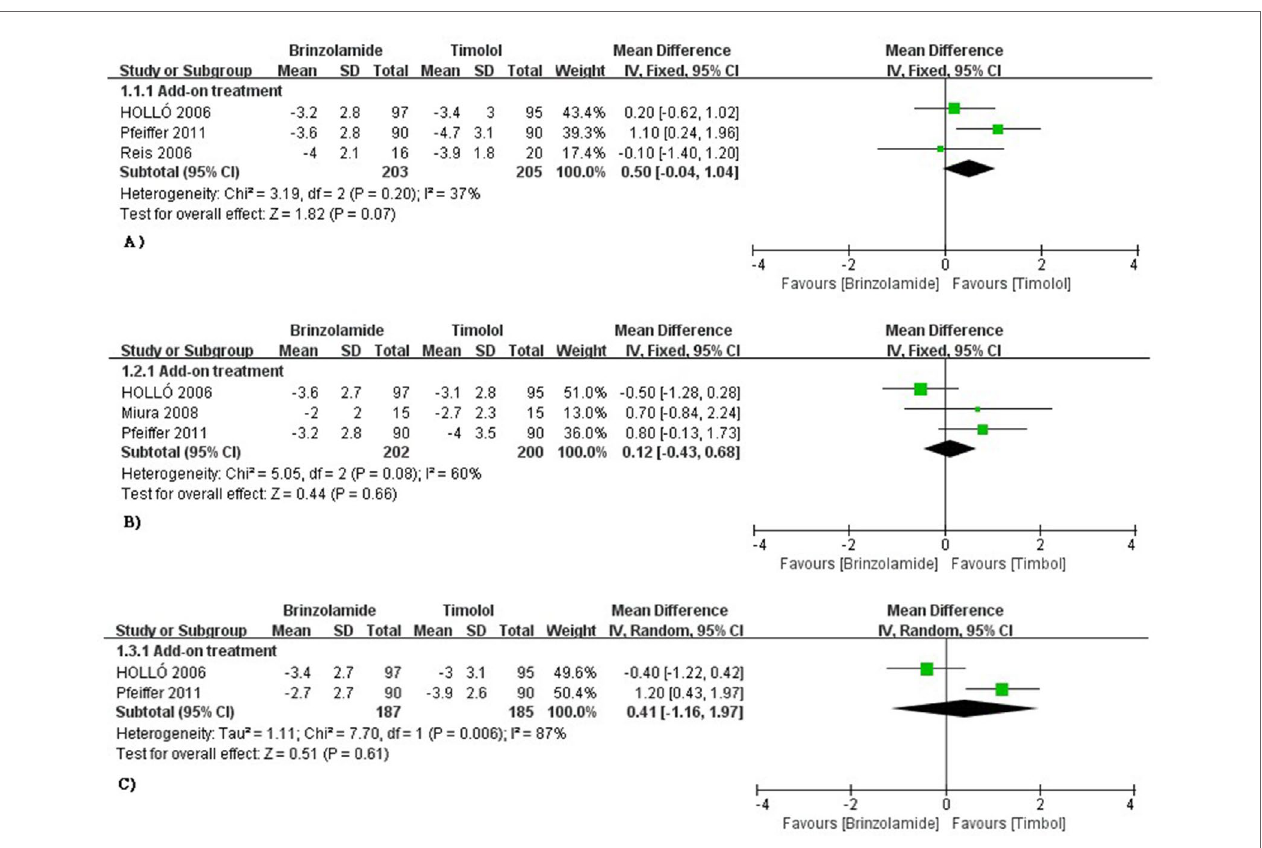
FIGURE 2 | Forest plot for IOP change from baseline (Brinzolamide group vs. Timolol group). The plot of change value for IOP at 9 am (A) , 12 am (B) , 4 pm (C)